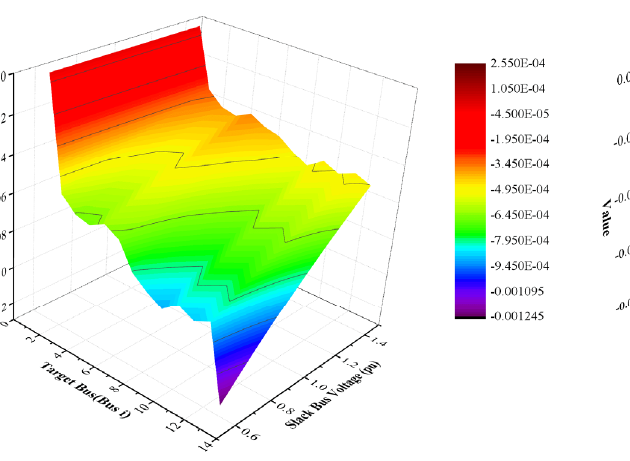
Figure 10. The results of Equation (40). ( a ) The injected power at bus 13 is − 1 MW; ( b ) The injected power at bus 13 is 0 MW; ( c ) The injected power at bus 13 is 1 MW; ( d ) The injected power at bus 7 is − 1 MW; ( e ) The injected power at bus 7 is 0 MW; ( f ) The injected power at bus 7 is 1 MW.